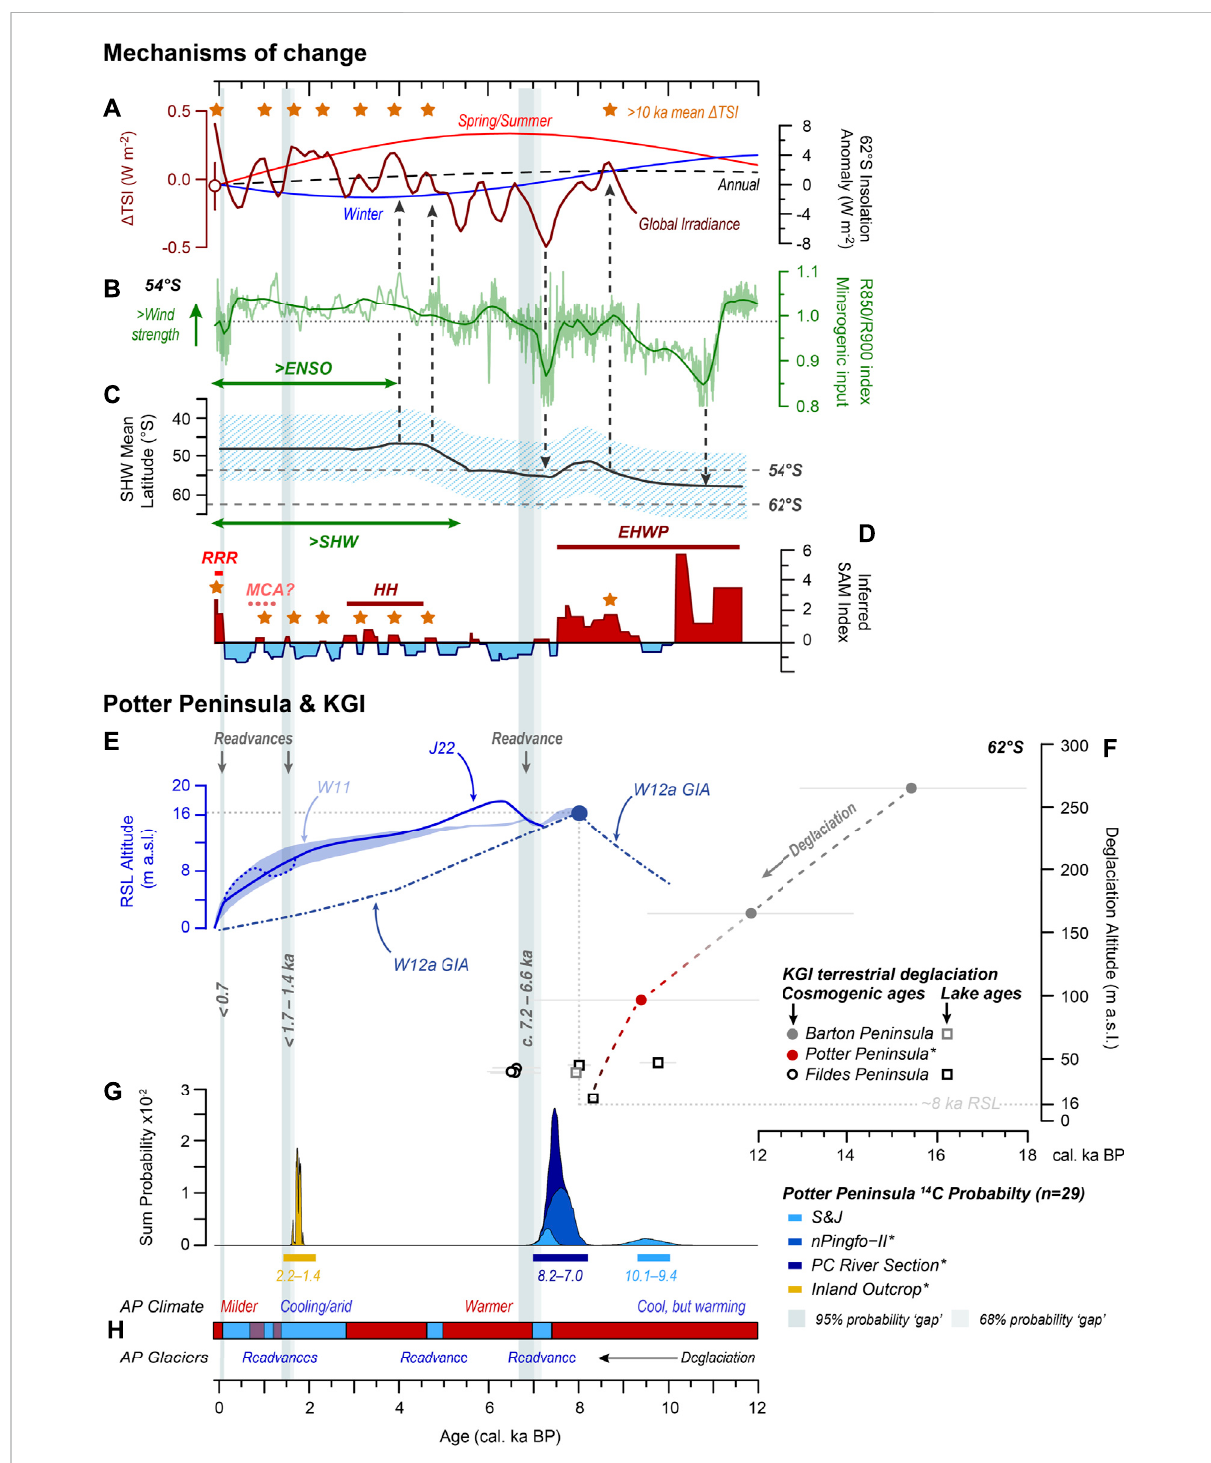
FIGURE 10 Mechanismsofdeglaciationandglacier fl uctuationsonPotterPeninsula. (A) TotalSolarIrradiance,as Δ TSI,whichrepresentsthedeviationfrom present-day value (Steinhilber et al., 2009), compared with annual (dashed black line), austral spring/summer (SONDJF) (red line), and winter (JJA) (blueline)solarinsolationreceivedat62 ° Sduring theHolocene(Laskaretal.,2004).Theopenredcircleisthemean±1 σΔ TSIvalueforthelast10ka; orange stars mark Δ TSI peaks greater than the 10 ka mean value. (B) Ultra-high resolution (69 μ m) hyperspectral (SPECIM) R850/R900 data, a proxy for mineral input into the Emerald Lake, Macquarie Island at 54 ° S (Saunders et al., 2018), which re fl ects changes in the Southern Hemisphere Westerly wind (SHW) strength during the mid-late Holocene; the dark grey horizontal dotted line is the R850/R900 dataset mean; dark green line is